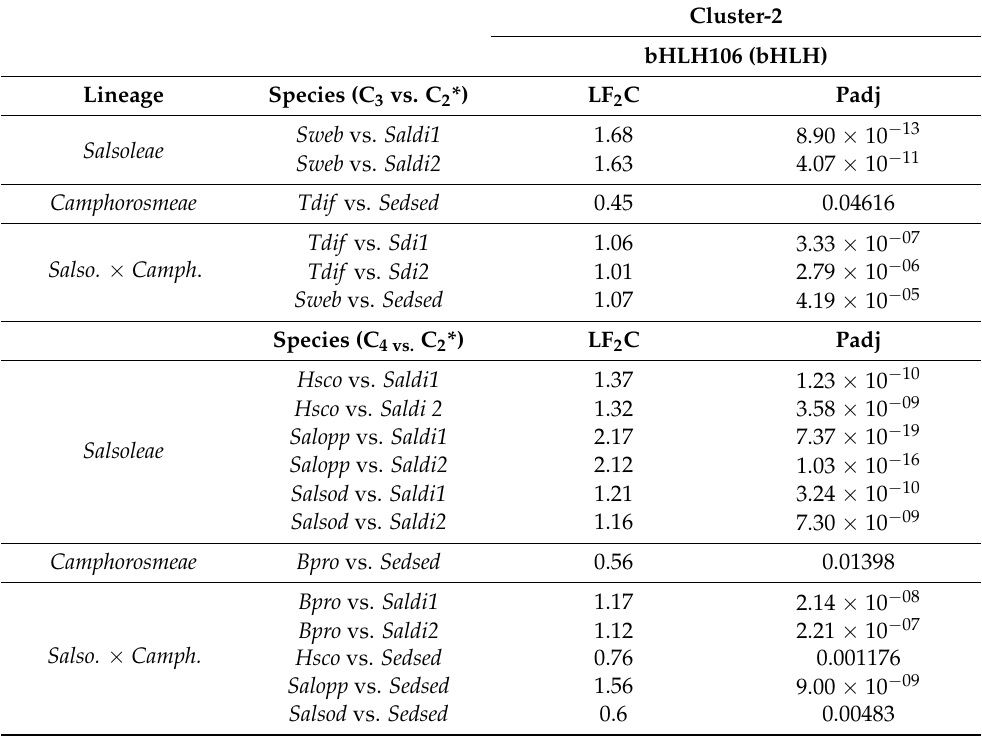
Table 5. Differentially expressed C 2 -related TF in Amaranthaceae / Chenopodiaceae